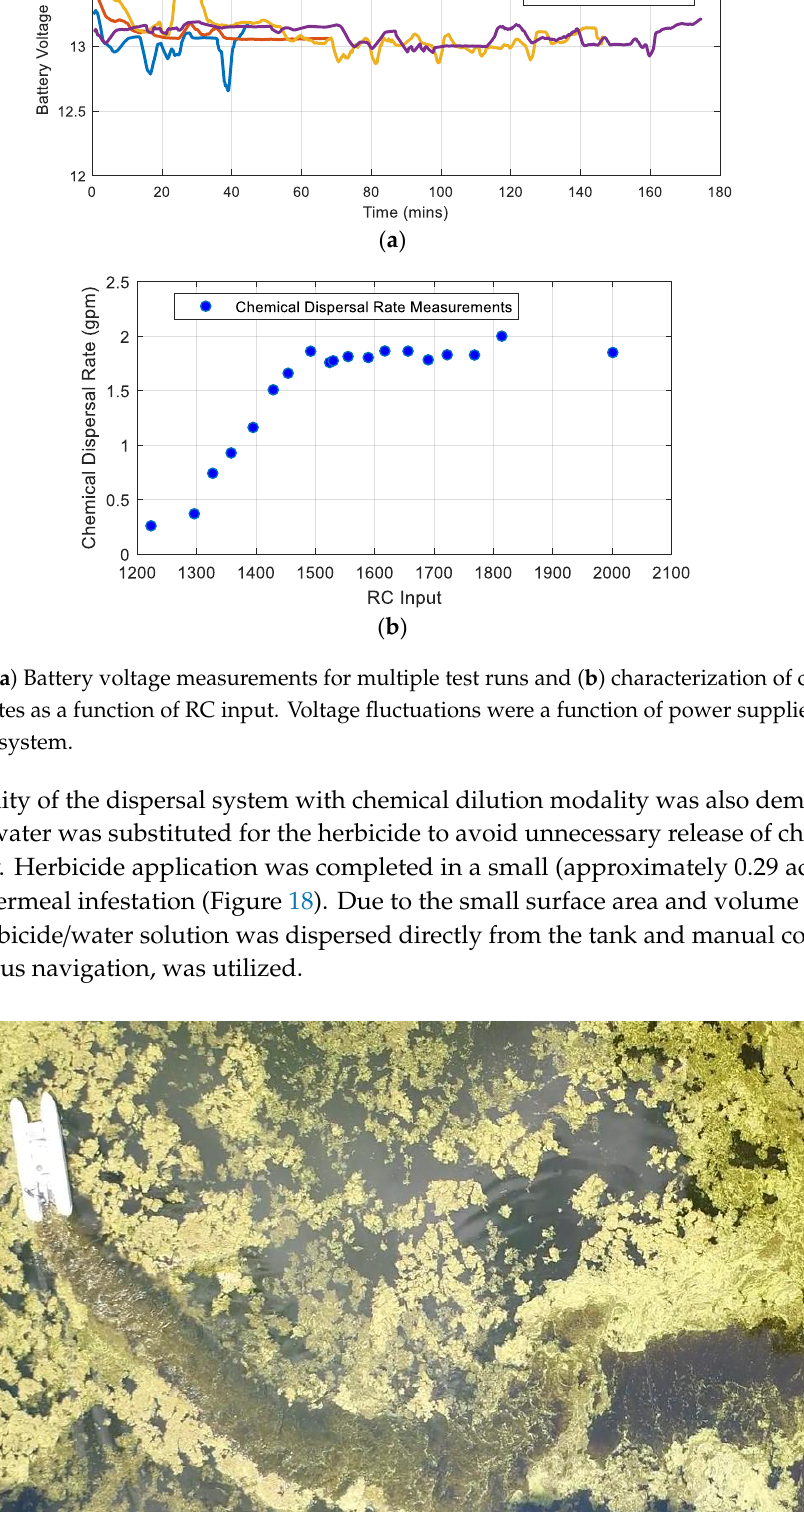
Figure 18. Treatment of watermeal infestation in a small pond using manual navigation and minimal prop submersion.